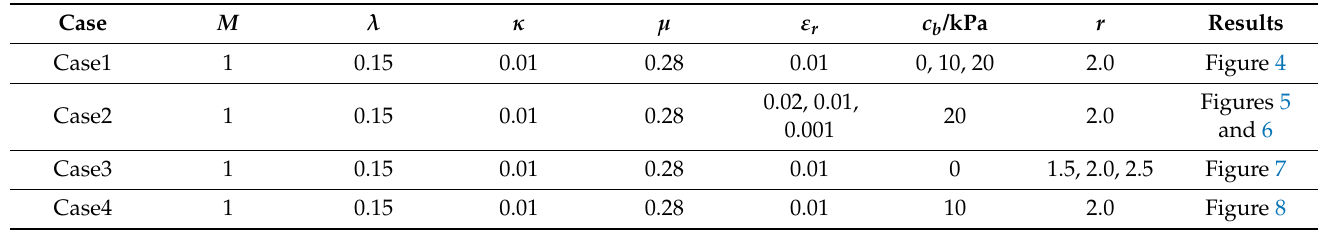
Table 2. Material parameters for case studies.